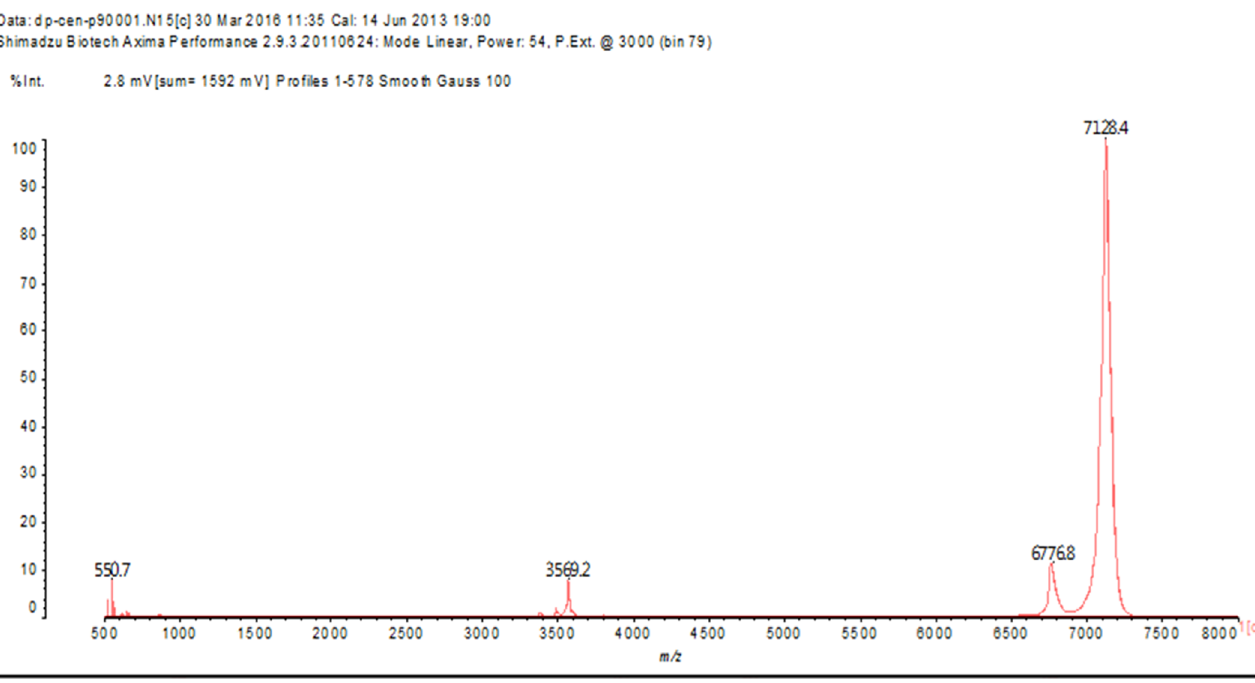
Kunitz-type peptide as an inhibitor of elastase-1 1.26 µM and 3.52 µM resulted in elastase inhibitions above